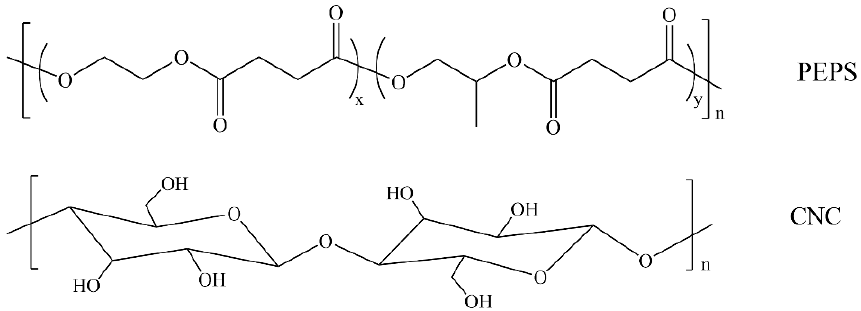
Figure 1. Chemical structures of PEPS and CNC.